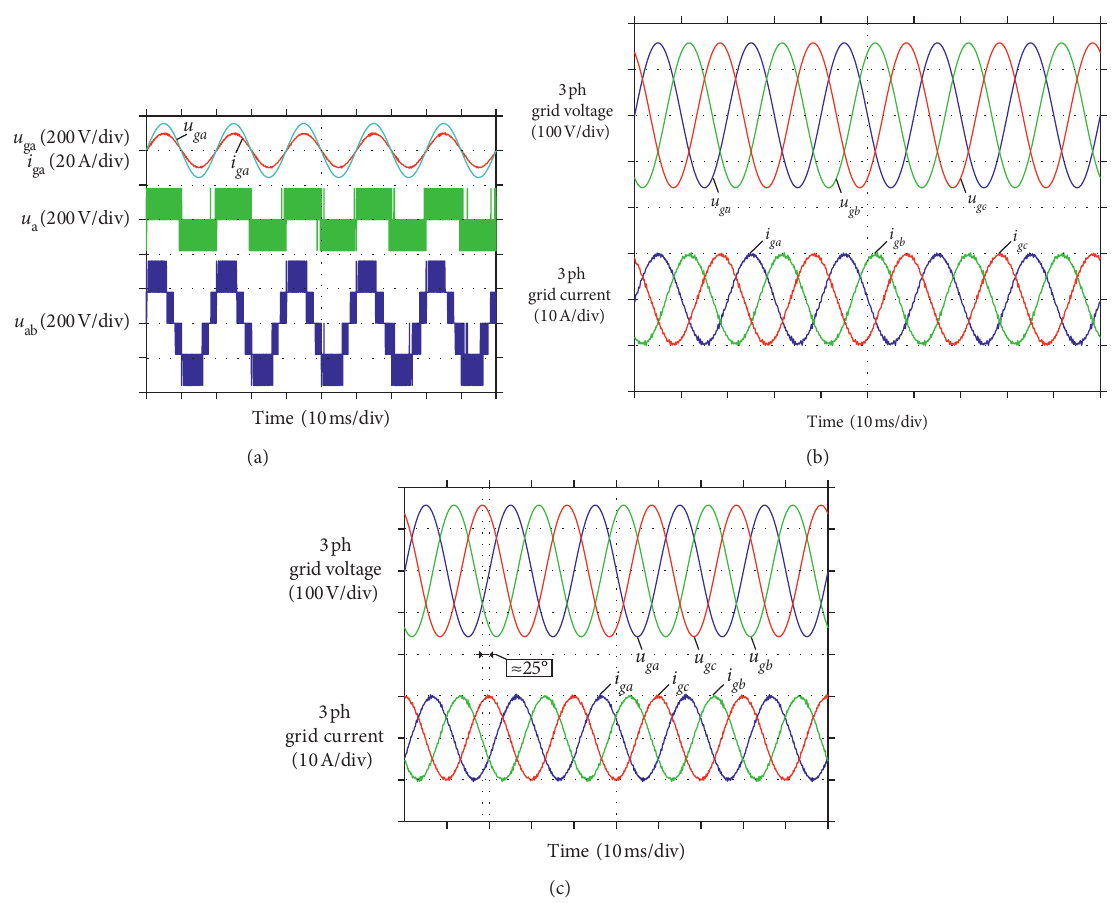
Figure 8: Simulation results of PCS in full load battery-discharging condition. (a) Waveforms of u (b) Waveforms of three-phase grid voltage and current (PF � 1.0). (c) Waveforms of three-phase grid voltage and current (PF �